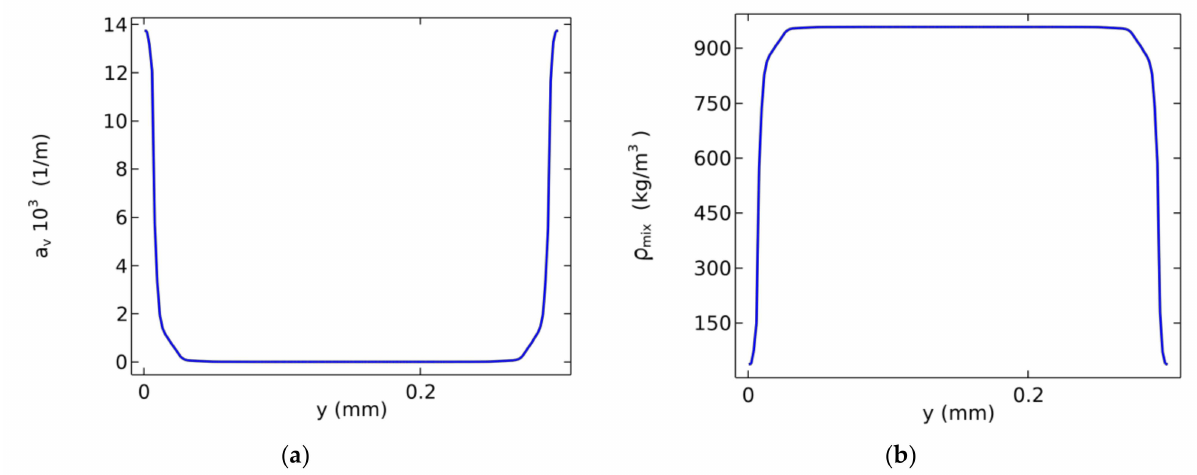
Figure 4. Transverse specific surface area ( a ) and mixture density ( b ) profiles in the microchannel. Boiling heat transfer in the microchannel. Transverse section z =